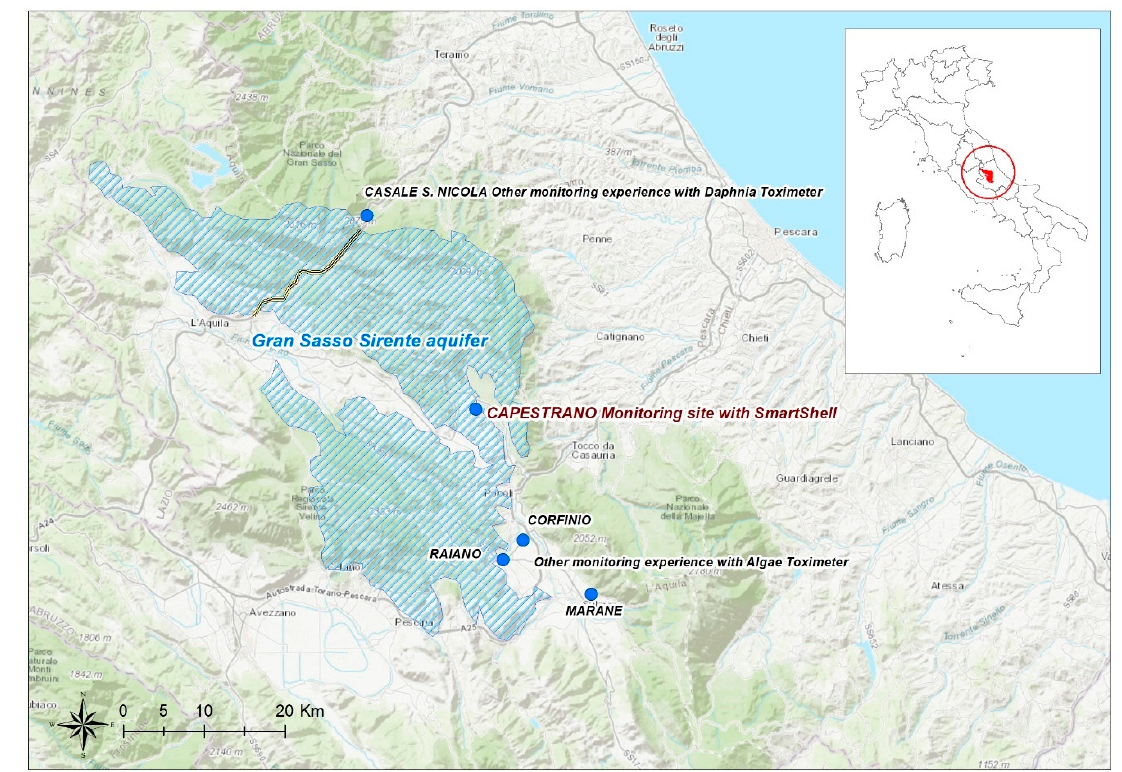
Figure 1. Map of the monitoring site in the GS-S aquifer where SmartShell has been installed and other water biomonitoring experience sites using BEWSs.